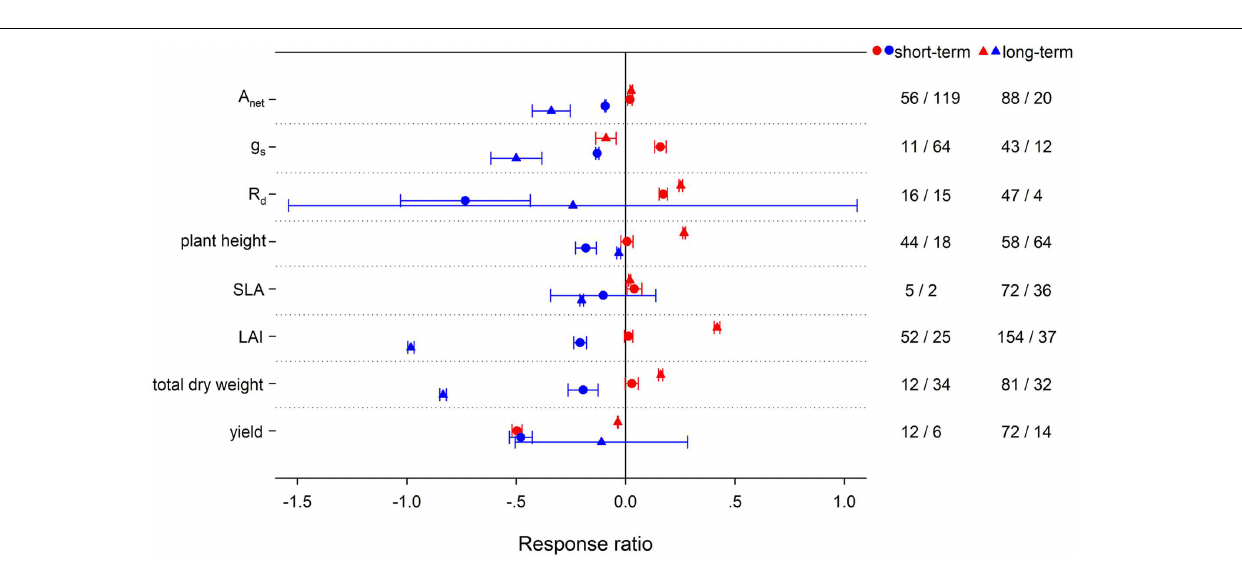
FIGURE 11 | Plant physiological, morphological and yield-related responses to HNT (red) and LNT (blue) for different treatment durations (circles, short-term; triangles, long-term). Each data point represents the mean ± 95% CI. The number of observations for each variable is given on the right of the